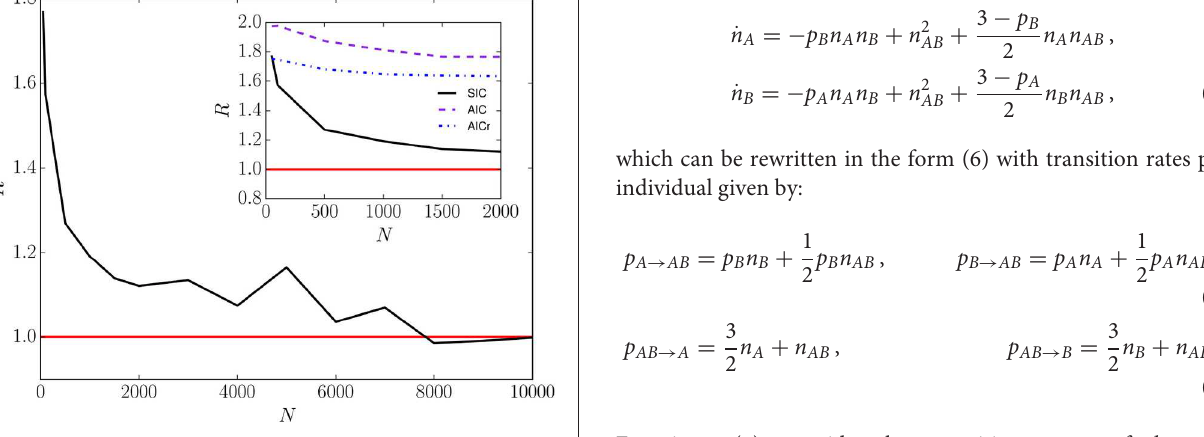
FIGURE 6 | The ratio of the convergence times of the Bayesian word-learning t conv / ¯ t conv vs. the system size model and the two-conventions NG model, R = N for a system starting with SIC. The inset illustrates the dependence of R on different initial conditions. The curves are obtained by averaging over 900 runs.